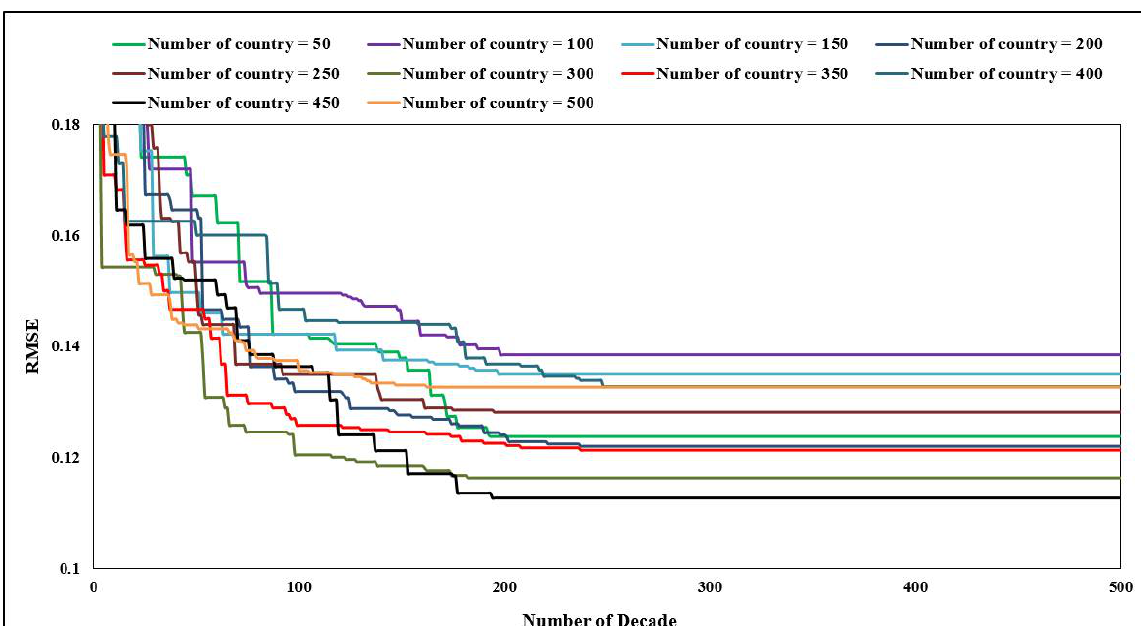
Figure 12. Ten ICA-ANN models and their RMSE results.